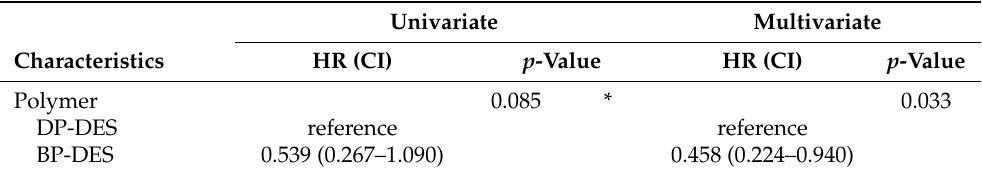
Table 3. Univariate and multivariate Cox regression analysis on all-cause mortality. Univariate